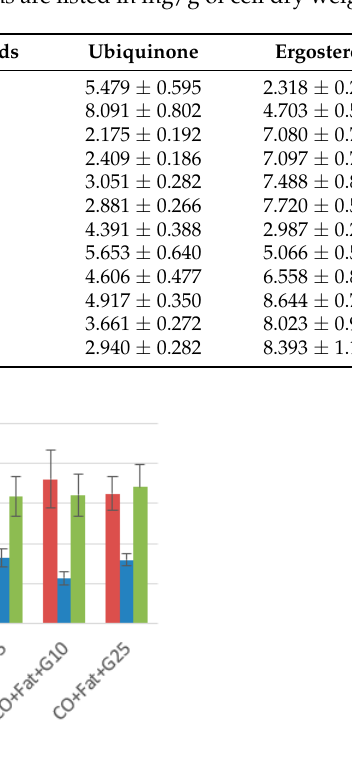
Table 6. HPLC analysis of Phase II screening cultivations Rhodotorula toruloides cultivated on waste lipid media with and without lipase induction. Productions are listed in mg/g of cell dry weight.